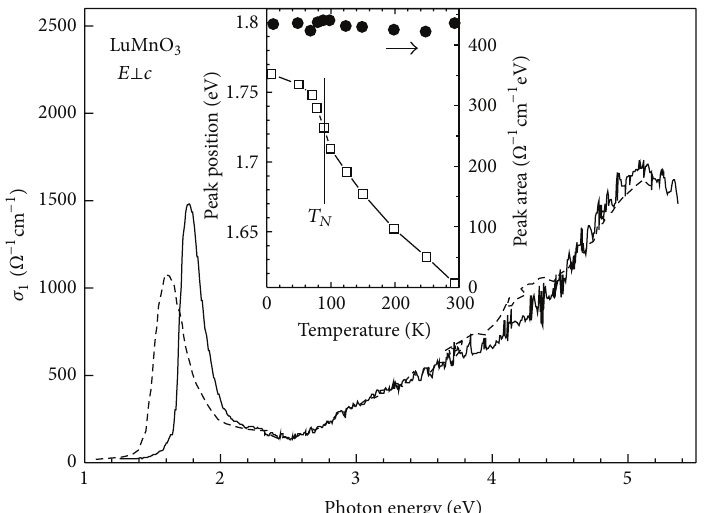
Figure 3: Electronic conductivity of LuMnO 3 at 300 K (dashed line) and 10K (solid line). Inset: temperature-dependent peak position (open squares) and spectral weight (solid circles) of the absorption peak around 1.7 eV [31]. Reprinted figure with permission from Souchkov et al. [31]. Copyright (2003) by the American Physical Society.